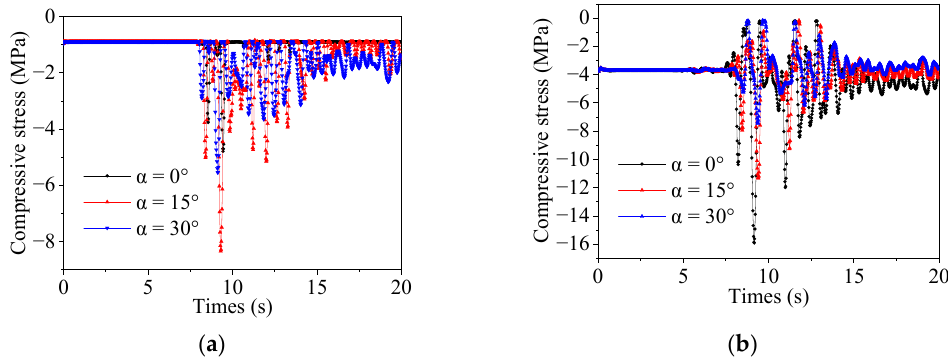
Figure 25. Compressive stress time history of the shear key: ( a ) shear key B; ( b ) shear key E.